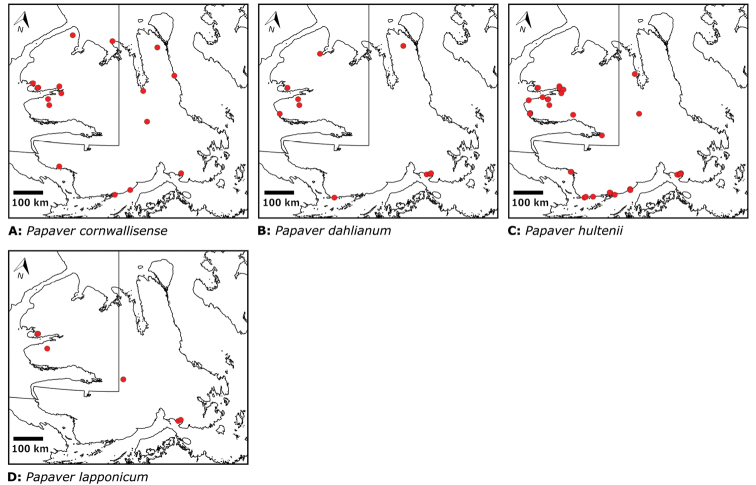
Species distribution maps. Papaveraceae: APapaver
cornwallisenseBPapaver
dahlianumCPapaver
hulteniiDPapaver
lapponicum.